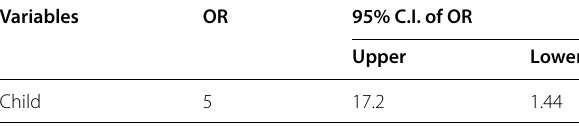
Table 7 Variables independently associated with poor outcome